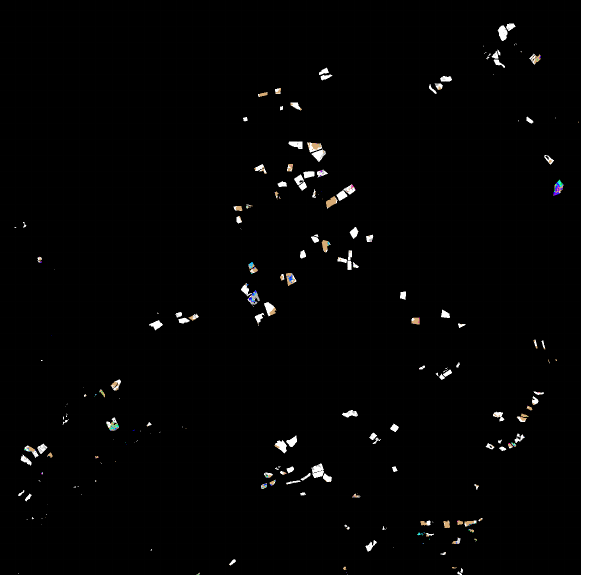
Figure 7. STL-map of the r 2 pattern, for areas identified as pastures by the DSLCC, in the region of la Plaine des Cafres .